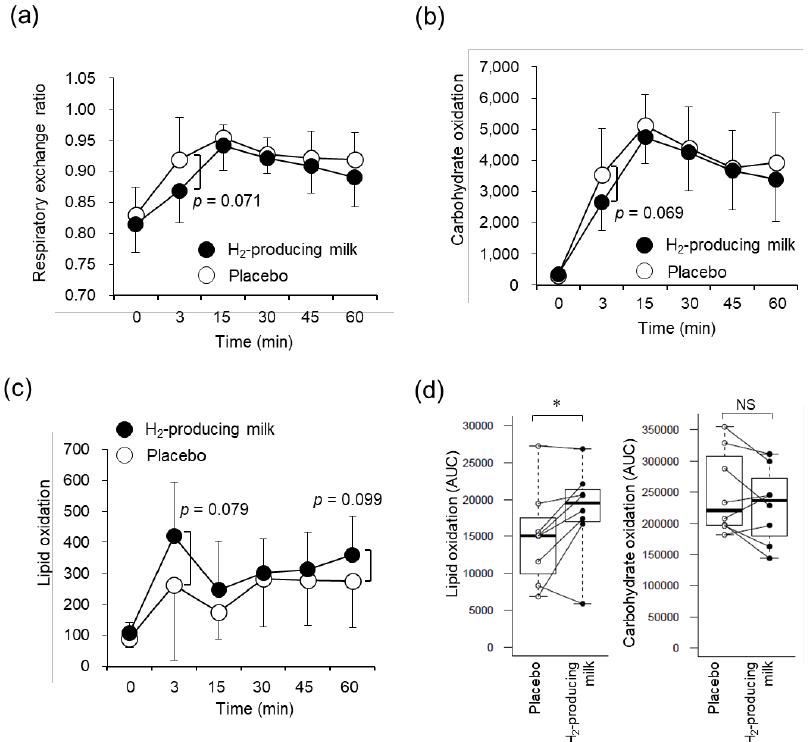
Figure 3. Effects of H 2 -producing milk and placebo use on energy metabolism during exercise. Time courses of the respiratory exchange ratio ( a ), lipid oxidation ( b ), and carbohydrate oxidation ( c ) during exercise are shown. Error bars represent the standard deviation of the mean. The black and white plots represent the means during the H 2 -producing milk and placebo trials, respectively. A comparison of the AUC for lipid oxidation and that for carbohydrate oxidation ( d ) is also shown (paired t -test, * p < 0.05). Each part of the boxplot diagram shows the following: upper line, maximum value; lower line, minimum value; box, interquartile range; bold line inside the box, median; and white and black plots, values during the placebo and H 2 -producing milk trials, respectively. AUC, area under the curve.